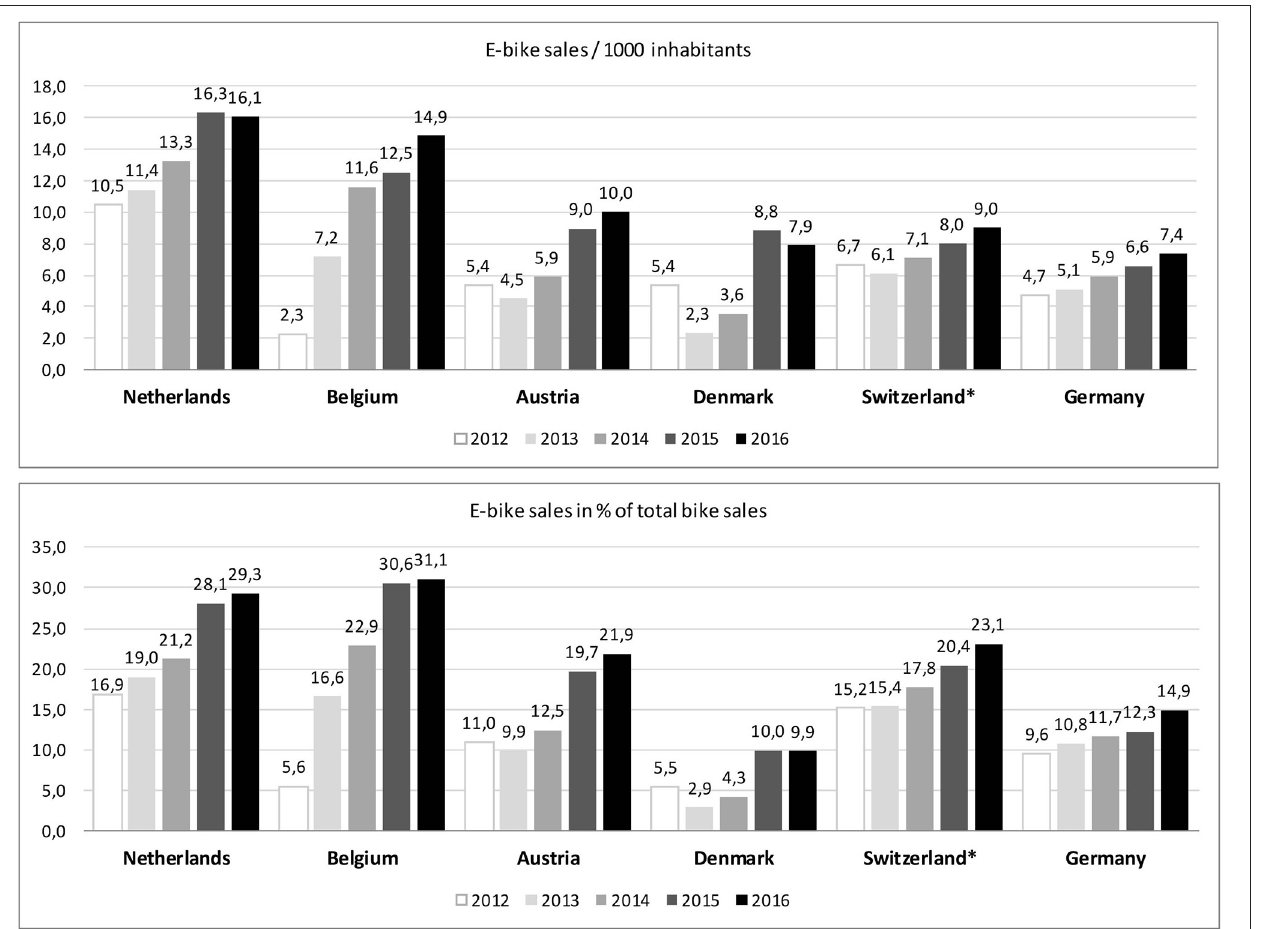
FIGURE 1 | Electric pedal-assisted bicycle sales per 1,000 inhabitants (left) and as share of total bike sales (right) in five European countries and Switzerland [data sources: CONEBI (2016); *Vélosuisse (2017); EUROSTAT (2017)].